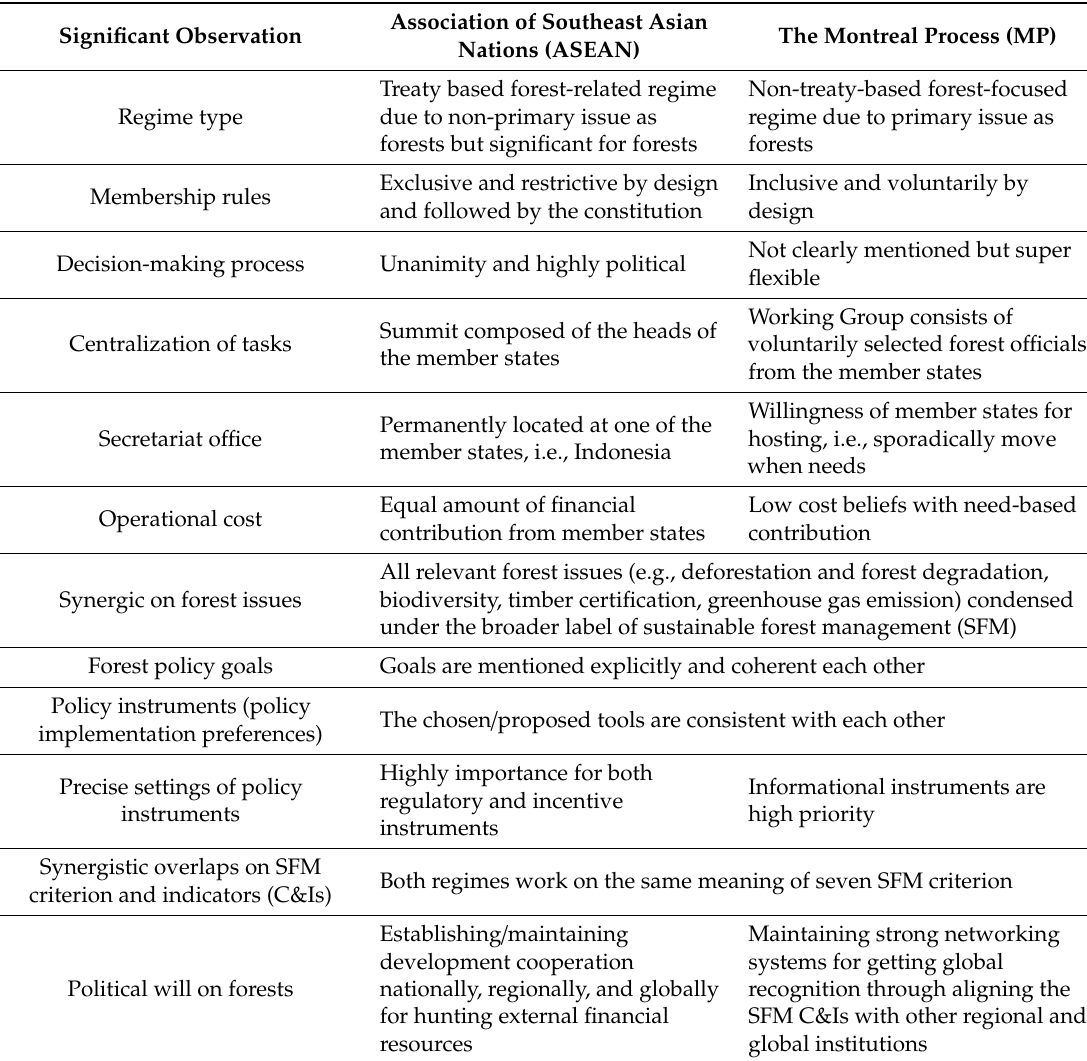
Table 5. Significant comparative observation between ASEAN and MP (Authors